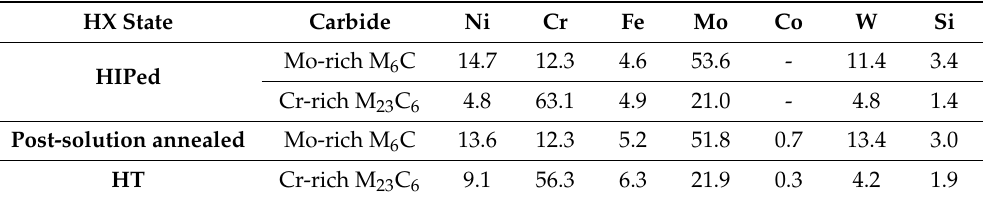
Figure 5. HT HX samples: ( a , b ) LOM images showing carbide precipitation along the grain boundaries; ( c ) BSE SEM micrograph with an EDS map showing enriched areas with Cr and Mo corresponding to Cr-rich M 23 C 6 carbides and Mo-rich M 6 C carbides, respectively; ( d ) secondary electron (SE) FE-SEM image showing grain boundaries covered by Cr-rich M 23 C 6 carbides. Kalling’s No.2 etchant was used. Table 2. EDS results in weight percentage of the extracted carbides from HIPed, post-solution annealed, and HT HX